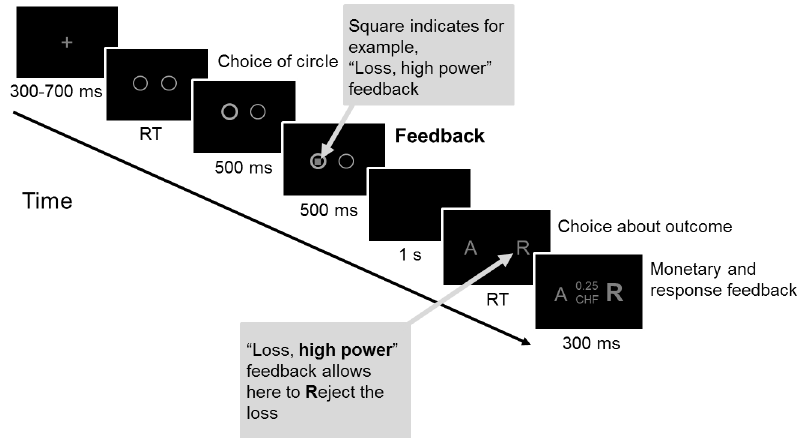
Fig 7. An example of a gambling task trial of Experiment 2. Presentation times of each trial event are indicated below the corresponding screen. At feedback onset, the information of goal conduciveness and power appraisals was simultaneously presented via a geometric shape in gray or black. A = accepting. R = rejecting. RT = reaction